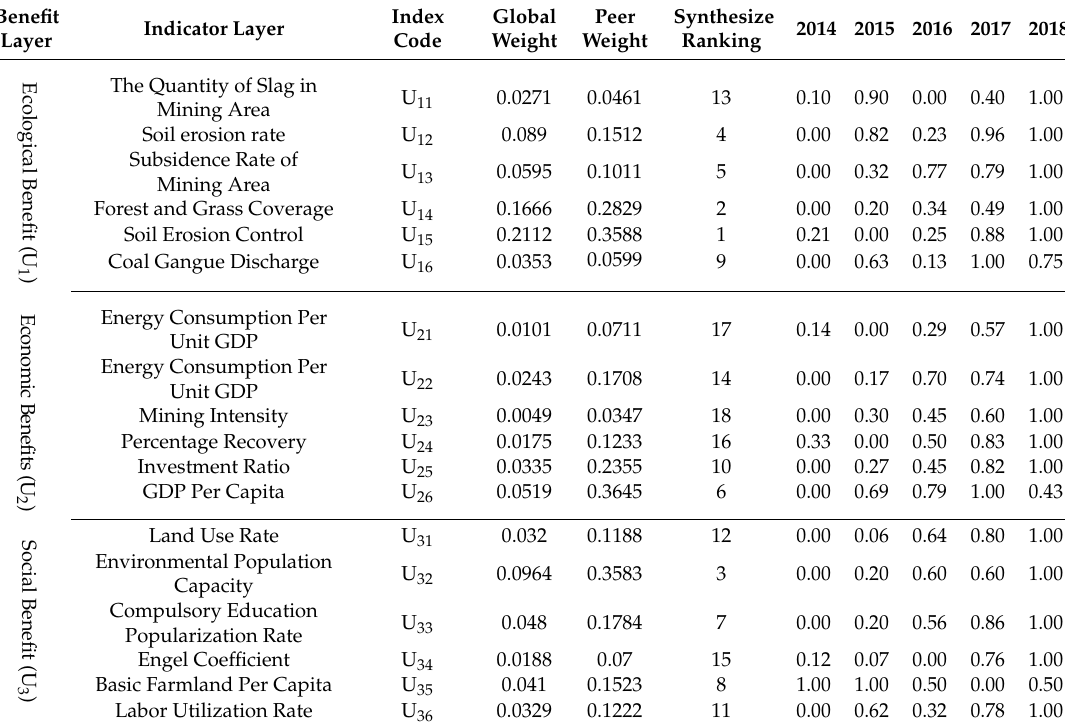
Table 8. Weight table for group decision-making in Shendong Coal Mining Subsidence